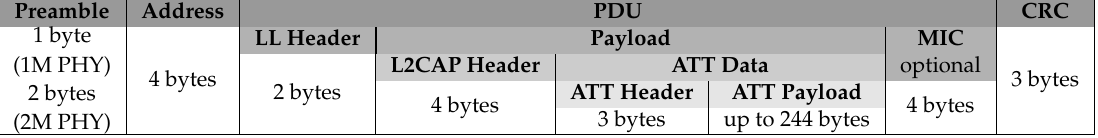
Figure 3. Packet format for uncoded Bluetooth 5 data